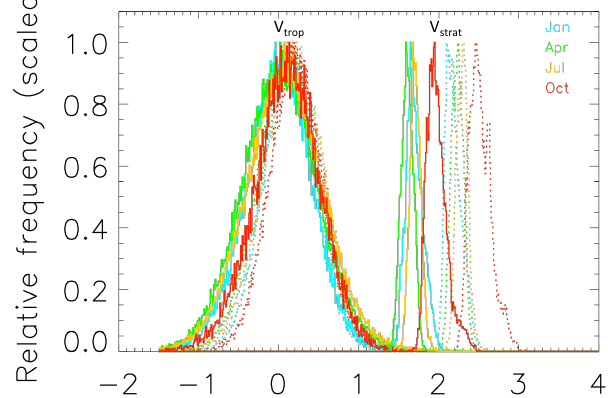
Figure 2. Probability distribution functions (PDFs) of the new SPv3 (solid lines) and previous version SPv2 (dashed lines) VCDs ( × 10 15 molec.cm − 2 ) retrieved in the Pacific region 15 ◦ S < lat < 5 ◦ S and 160 ◦ E < lon < 130 ◦ W during 2011. The width of the V trop is used as proxy for estimated noise in V trop ∼ 0.5 × 10 15 molec.cm − 2 (Table 2).